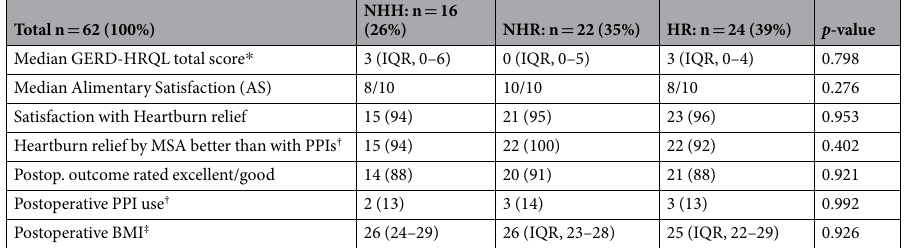
Table 3. Postoperative outcomes and Quality of Life results based on surgical procedure. Error analysis: standard deviation. Numbers provided in tables are medians (IQR). * GERD-HRQL total score ranges from 0–50; † PPI(s) = Proton pump inhibitors; ‡ BMI: Body Mass